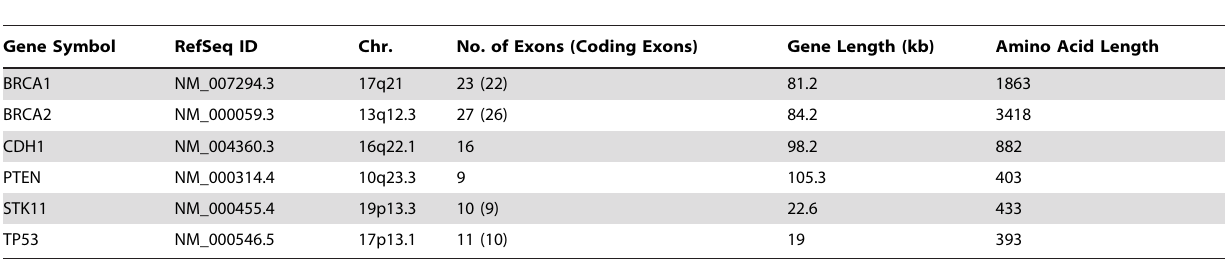
Table 1. High-risk hereditary breast cancer genes analyzed on the BRCAPlus panel.